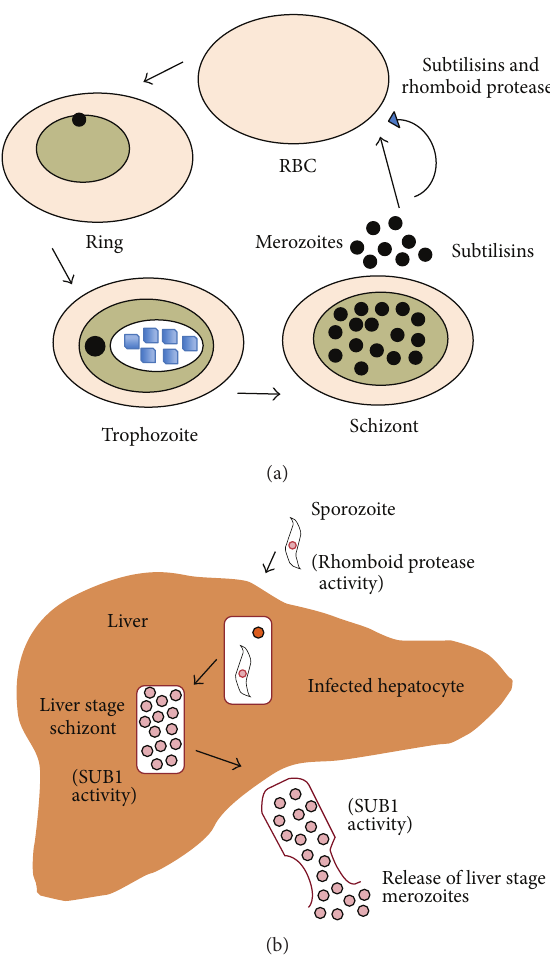
Figure 1: Role of serine proteases at asexual blood stages (a) and liver stages of Plasmodium falciparum (b). Subtilisin-like proteases are essential for merozoite invasion and egress in blood stages, liver stage schizont development and subsequent liver stage merozoite egress. Rhomboid protease activities are supposed to be involved in invasion of RBC and